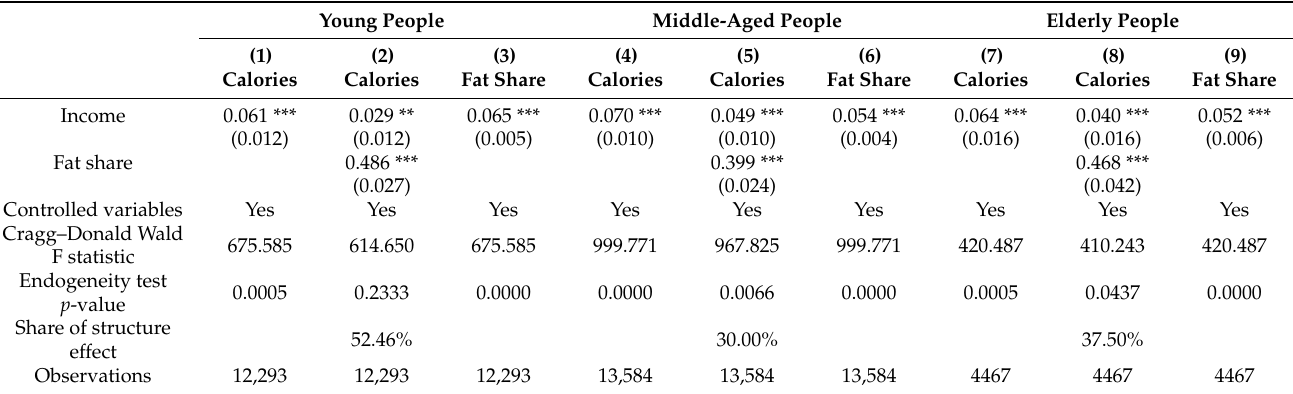
Table 5. The effect of income on calorie consumption for different age